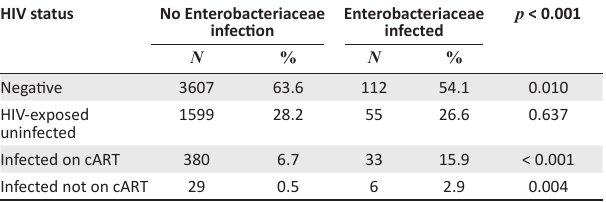
FIGURE 2: Multiple logistic regression analysis of human immunodeficiency virus status and nutrition and Enterobacteriaceae TABLE 3: Human immunodeficiency virus status and Enterobacteriacae infections. HIV status